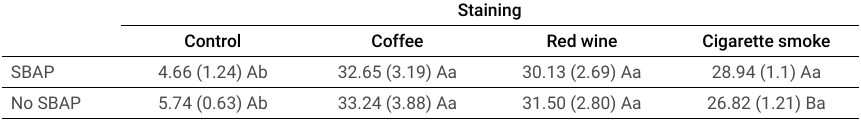
Table 3. ΔE means (Standard Deviations) according to the